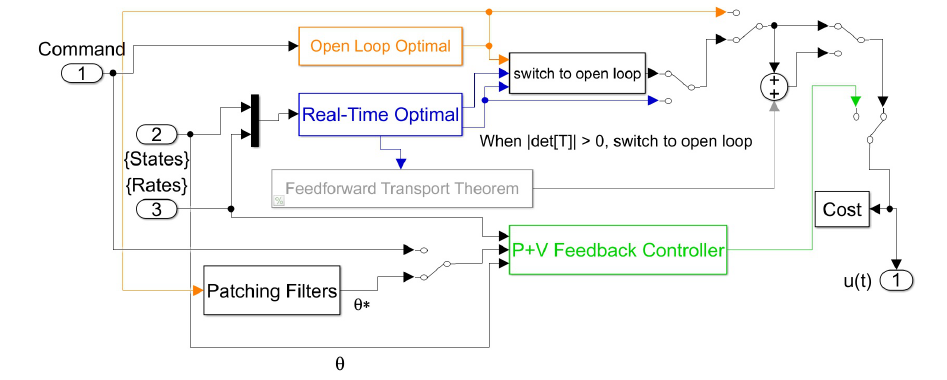
Figure A3. Double-integrator plant to convert input control τ into state and rate data. Including the transport theorem was not done; however, one could add it here if desired.